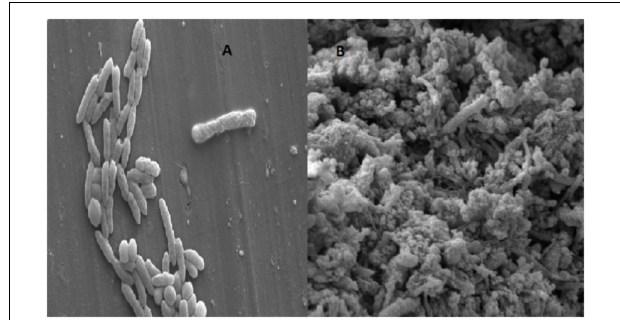
FIGURE 5 | Morphology of the indigenous consortia TERIJ-188. (A) Scanning electron micrograph of 5 days grown culture in Baltech media at 15KX magnification, bar 2 µ m. (B) 10 days grown culture clearly showing criss cross network of bio-surfactant.